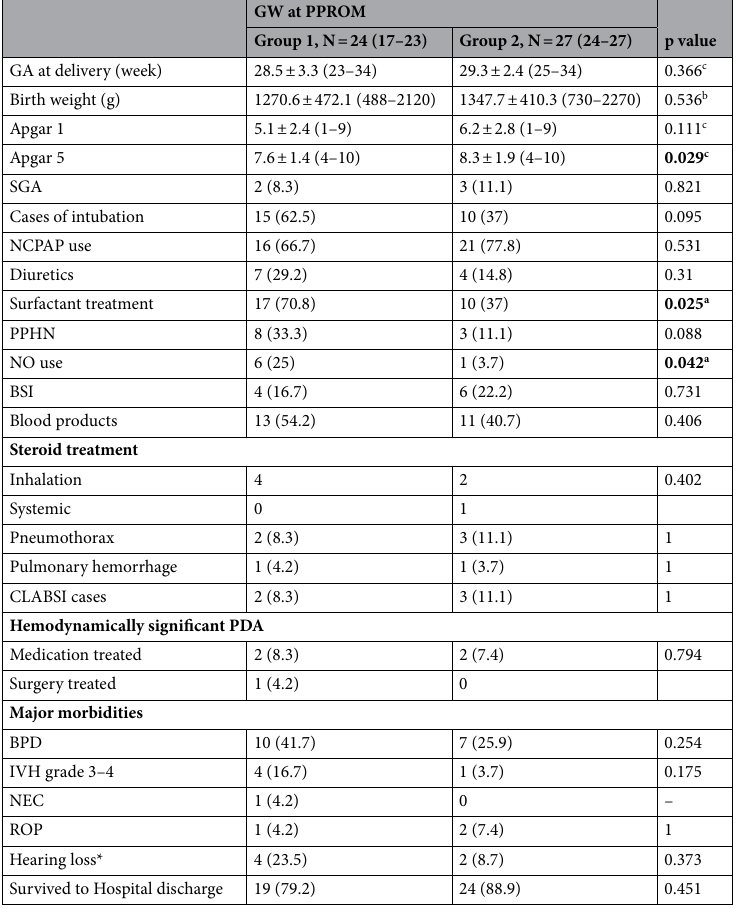
Table 2. Neonatal outcomes by gestational week (GW) at PPROM. GA gestational age, GW gestational week, SGA small for gestational age, NCPAP nasal continuous positive airway pressure, BDP bronchopulmonary dysplasia, IVH intraventricular hemorrhage, PPHN persistent pulmonary hypertension of the newborn, NO nitric oxide, NEC necrotizing enterocolitis, BSI blood stream infection, ROP Retinopathy of prematurity, CLABSI Central Line Associated Bloodstream Infections, PDA Patent ductus arteriosus, NA not assessed. a Fisher’s Exact Test, followed by Phi Coefficient calculation. b t-test. c Mann–Whitney test. *10 missing value. Significant values are in